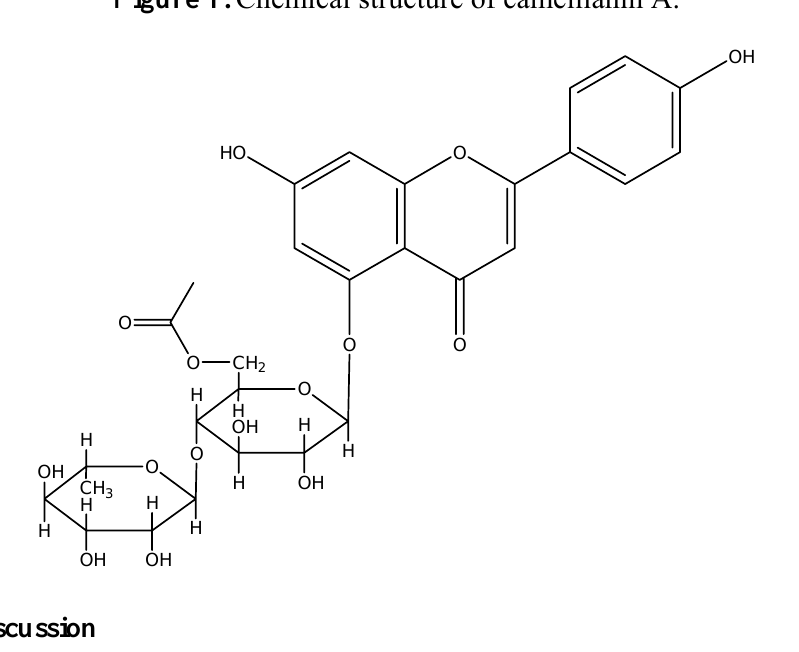
Figure 1. Chemical structure of camellianin